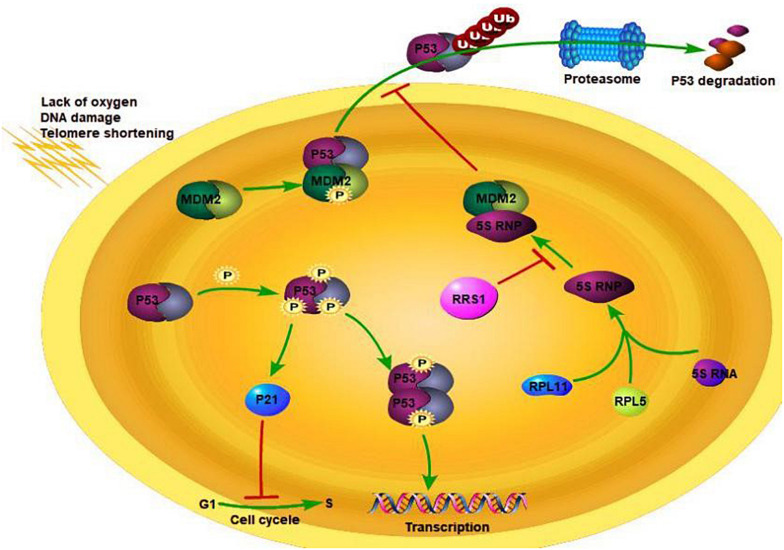
RSS1 regulation mechanism. Adapted from Cao (2019).